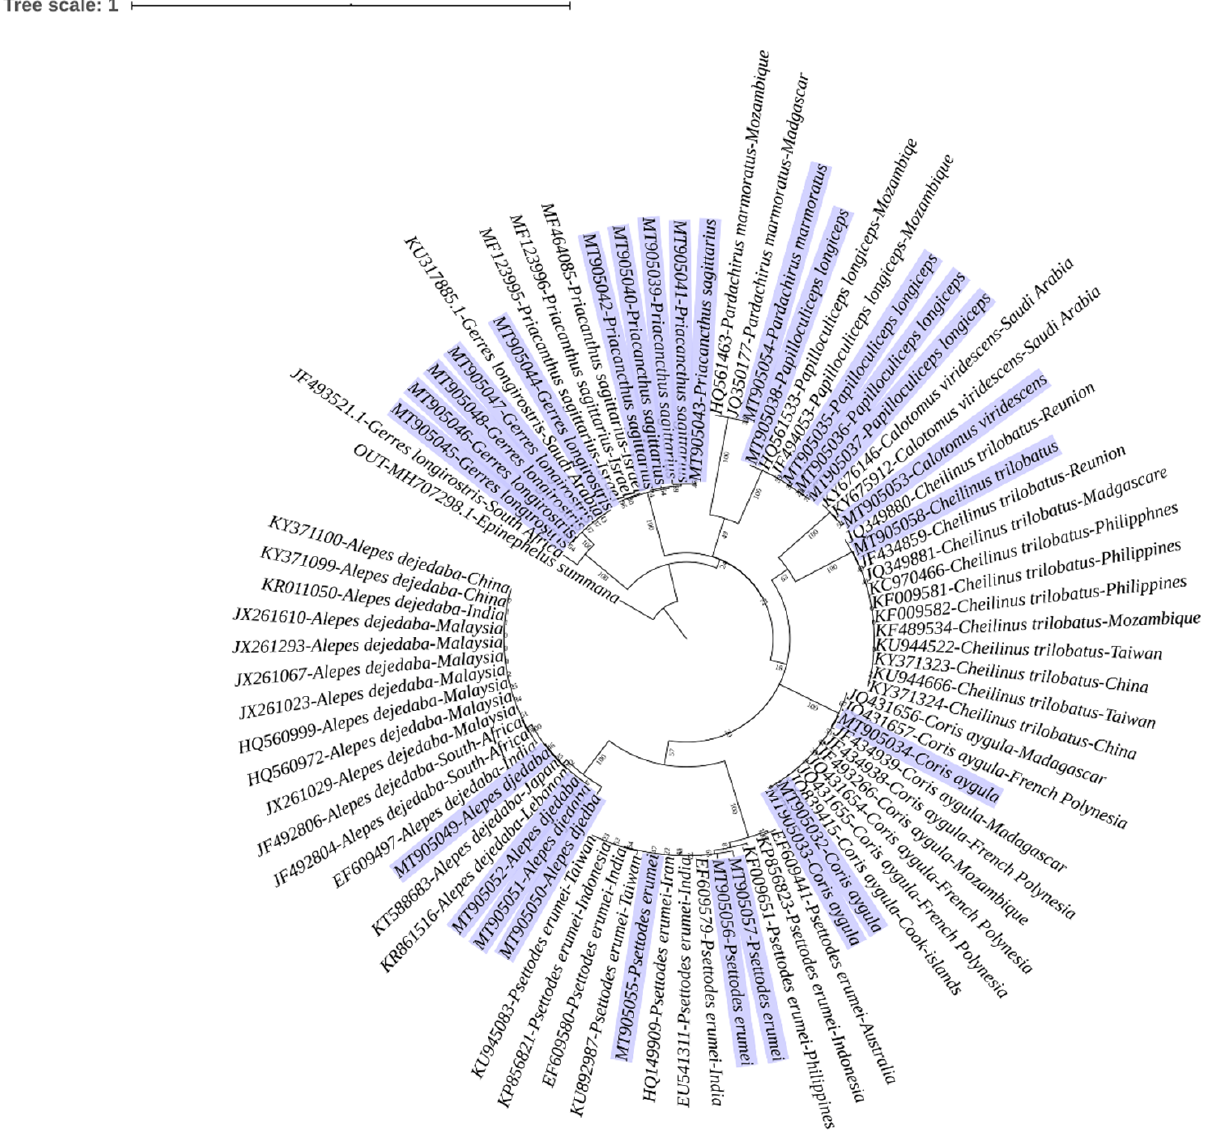
Fig. 4. BI phylogenetic analysis for the samples collected in the current study. four Markov Chains Monte Carlo (MCMC) chains were analyzed for 10 million (ngen =10,000,000) generations. Bootstrap values are shown above the branches. Samples collected from Suez City market are highlighted by light